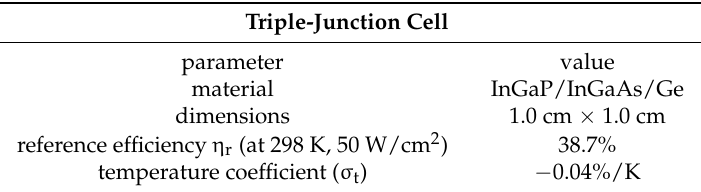
Figure 2. Linear focus experimental plant: ( a ) Triple-junction solar cell; ( b ) cooling fluid circuit; ( c ) experimental CPV/T system. Table 1. Cell characteristics [18].